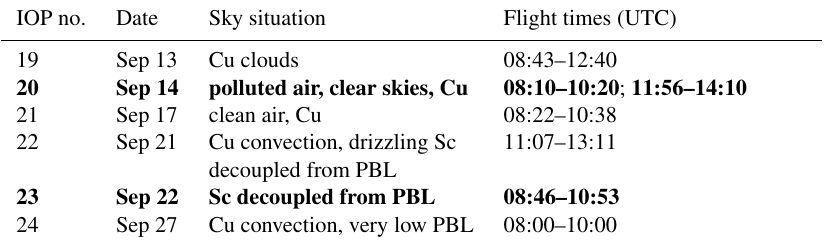
Table 4. Summary of intensive observation periods during HOPE-Melpitz. On these days a total of 15h of observations with ACTOS were performed. Cu: cumulus; Sc: stratocumulus. Bold typeface denotes “golden days”. IOP